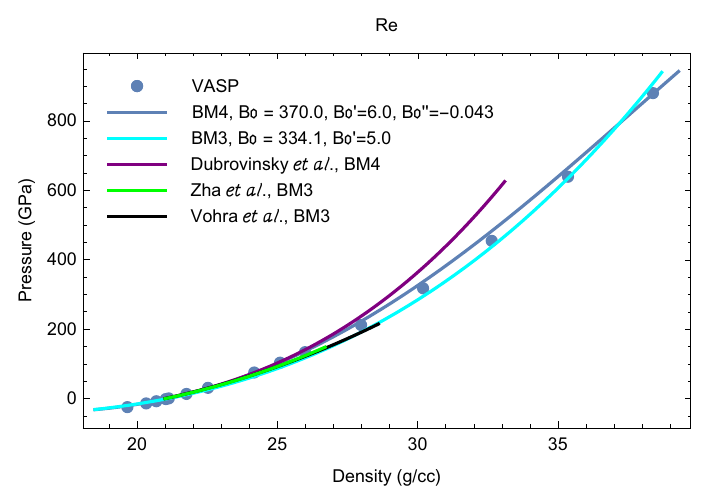
Figure 5. The T =0 Re EOS from VASP compared to the experimental 300 K EOSs from different Figure 9. The T = 0 Re EOS from VASP compared to the experimental 300 K EOSs from different literature literature sources [3,4,38]. The pressure ranges of the experimental EOSs are those in which they were sources [3,4,39]. The pressure ranges of the experimental EOSs are those in which they were measured. measured.